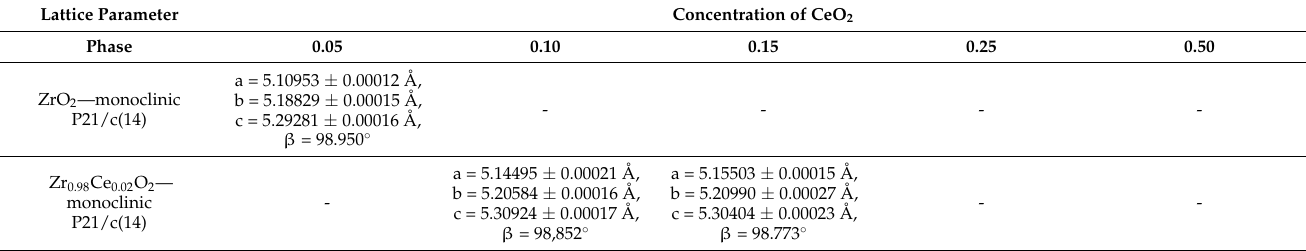
Table 1. Data on the crystal lattice parameters of the studied ceramic samples (the parameters were determined using the Rietveld